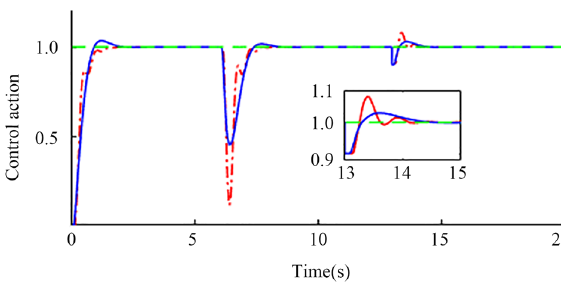
Figure 13. Perturbation response when the step signal is input.